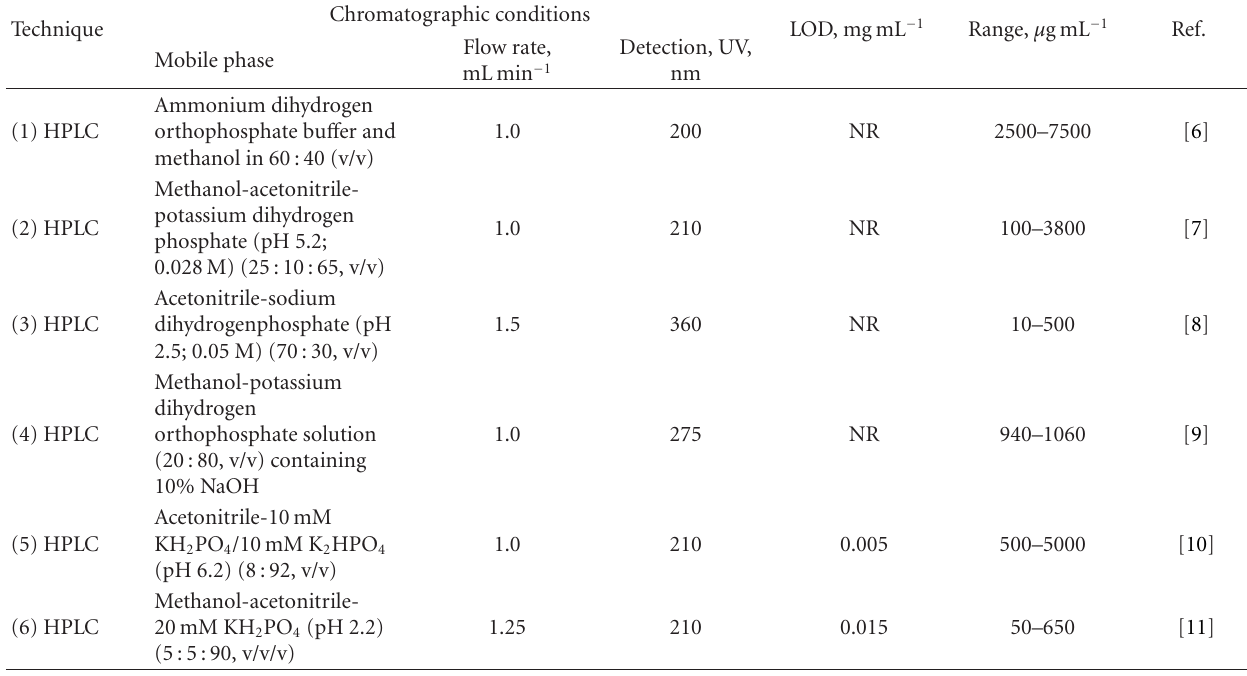
Table 1: Chromatographic methods reported for the determination of GBP in